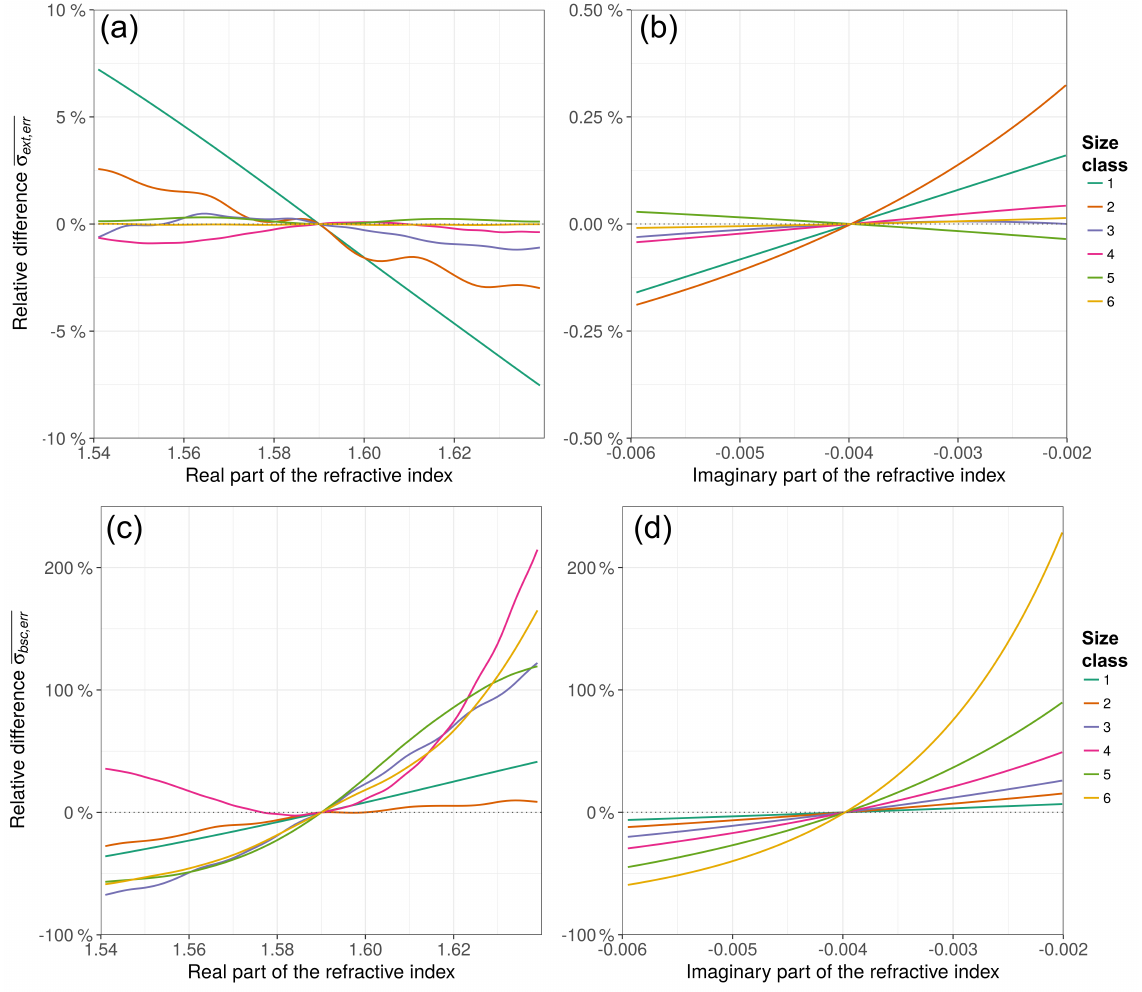
Figure 6. Relative errors of the effective extinction cross section (a, b) and of the effective backscatter cross section (c, d) if the assumed reference refractive index (1 . 59 − 0 . 004 i ) varies from the true refractive index. Uncertain real parts of the refractive index (a, c) may lead to errors of 7% for the effective extinction cross section as well as of 225% for the effective backscatter cross section. Uncertain imaginary parts of the refractive index (b, d) may lead to a maximum error of 0.5% for the effective extinction cross section and of 230% for the effective backscatter cross section. The maximum error was observed at the outer range of considered refractive indices. Therefore, reducing the considered range of refractive indices reduces the maximum error of the effective extinction and backscatter cross